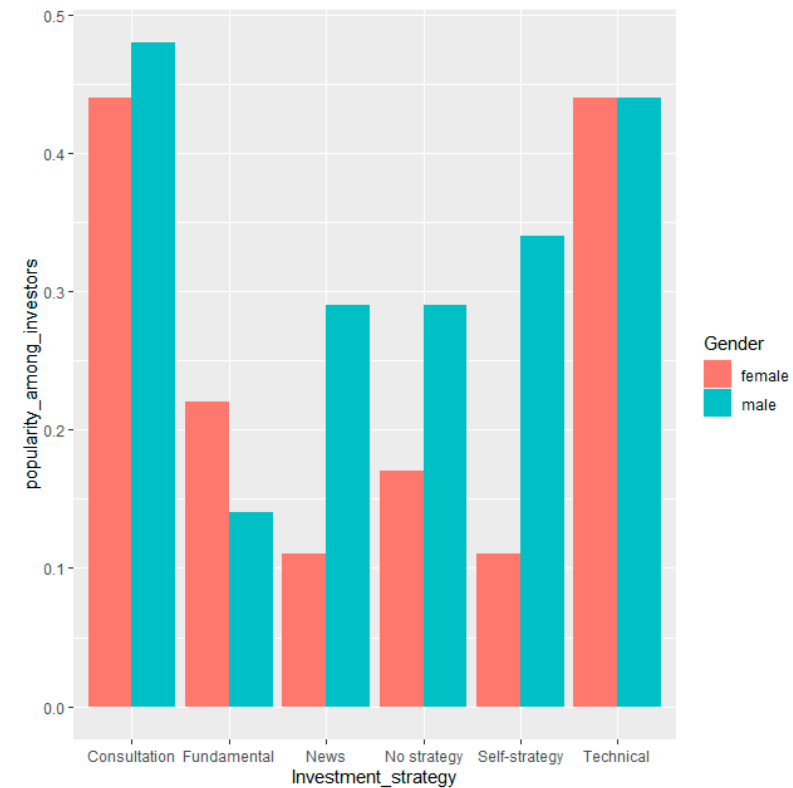
Figure 2. Adopted investment approaches on TSE based on gender.